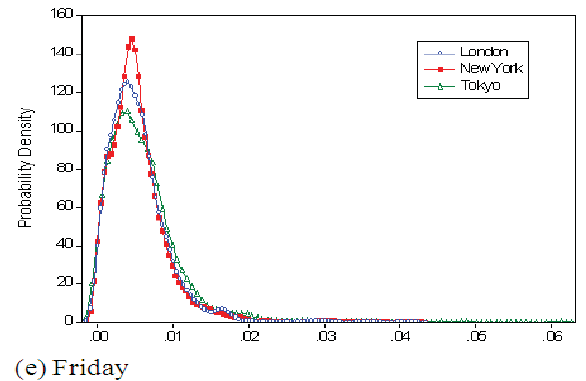
Fig. 7. Probability distributions of gold volatility from Monday to Friday in London, New York and Tokyo